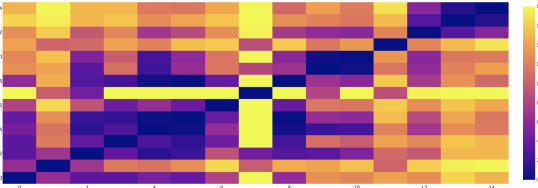
Figure 8. Heatmap for feature-based distance among all hotspot locations.